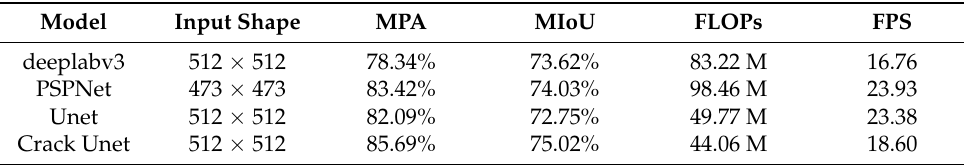
Table 2. Comparison of indexes from different models.